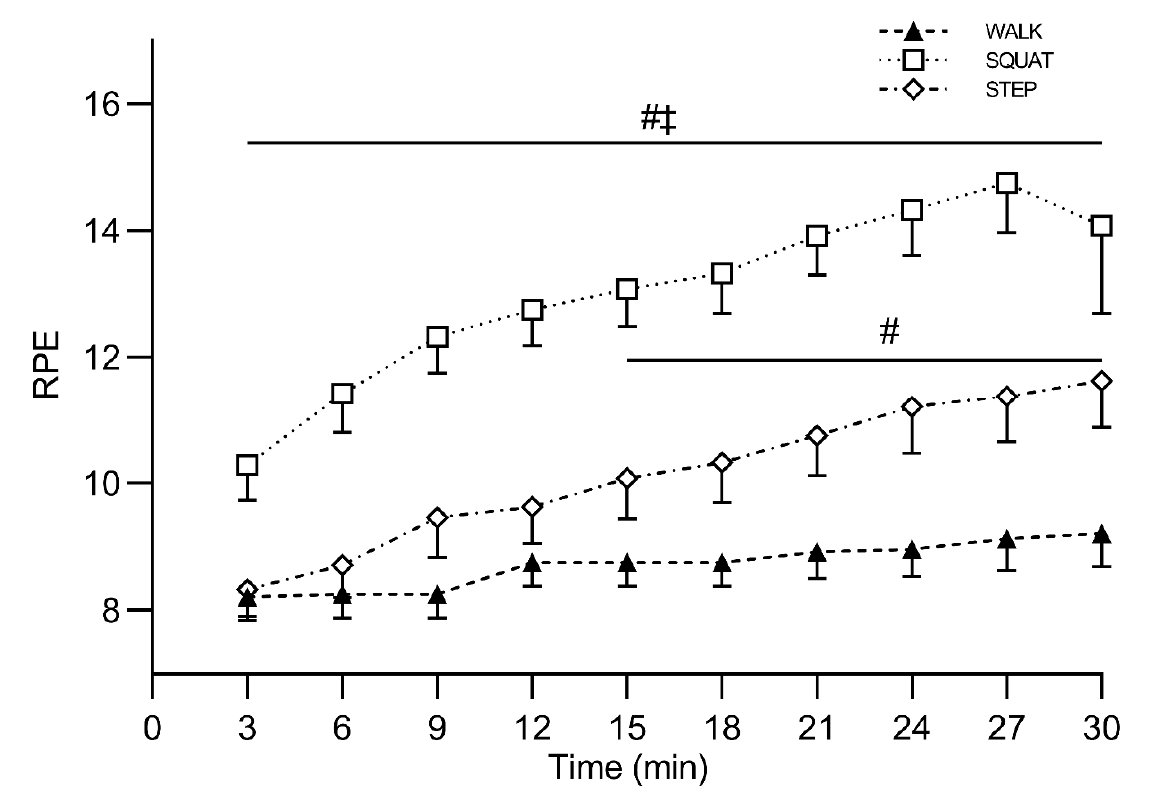
Figure 3. Rate of perceived exertion (6–20 RPE) during exercise, for Study 1. Symbols: #, p < 0.05 vs. WALK; ‡, p < 0.05 vs. STEP. Values are reported as mean (± SEM).